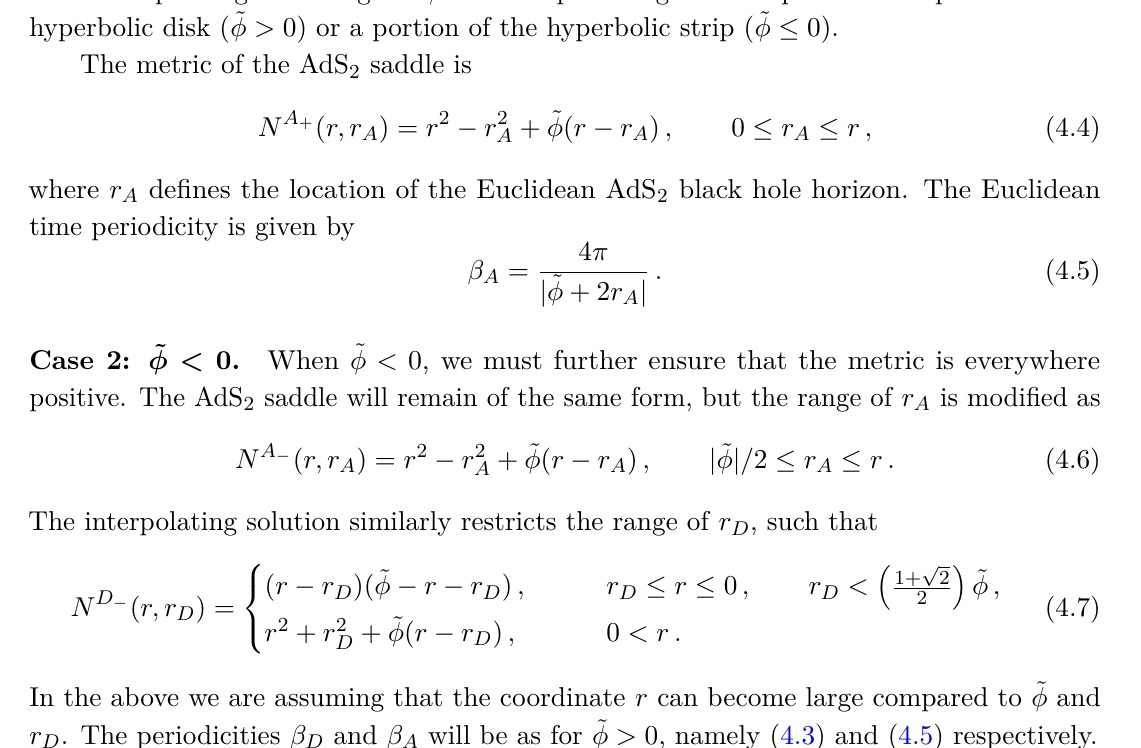
Figure 3 . The dilaton potential for the interpolating geometry (4.1) with ˜ φ > 0 . The blue slope indicates where the potential describes a dS 2 geometry and the red slope shows where the geometry is Euclidean AdS 2 . At a given temperature, there can be two saddles, indicated here at r D and r A . metric. Depending on the sign of ˜ φ the two-sphere is glued to a portion of a quotient of